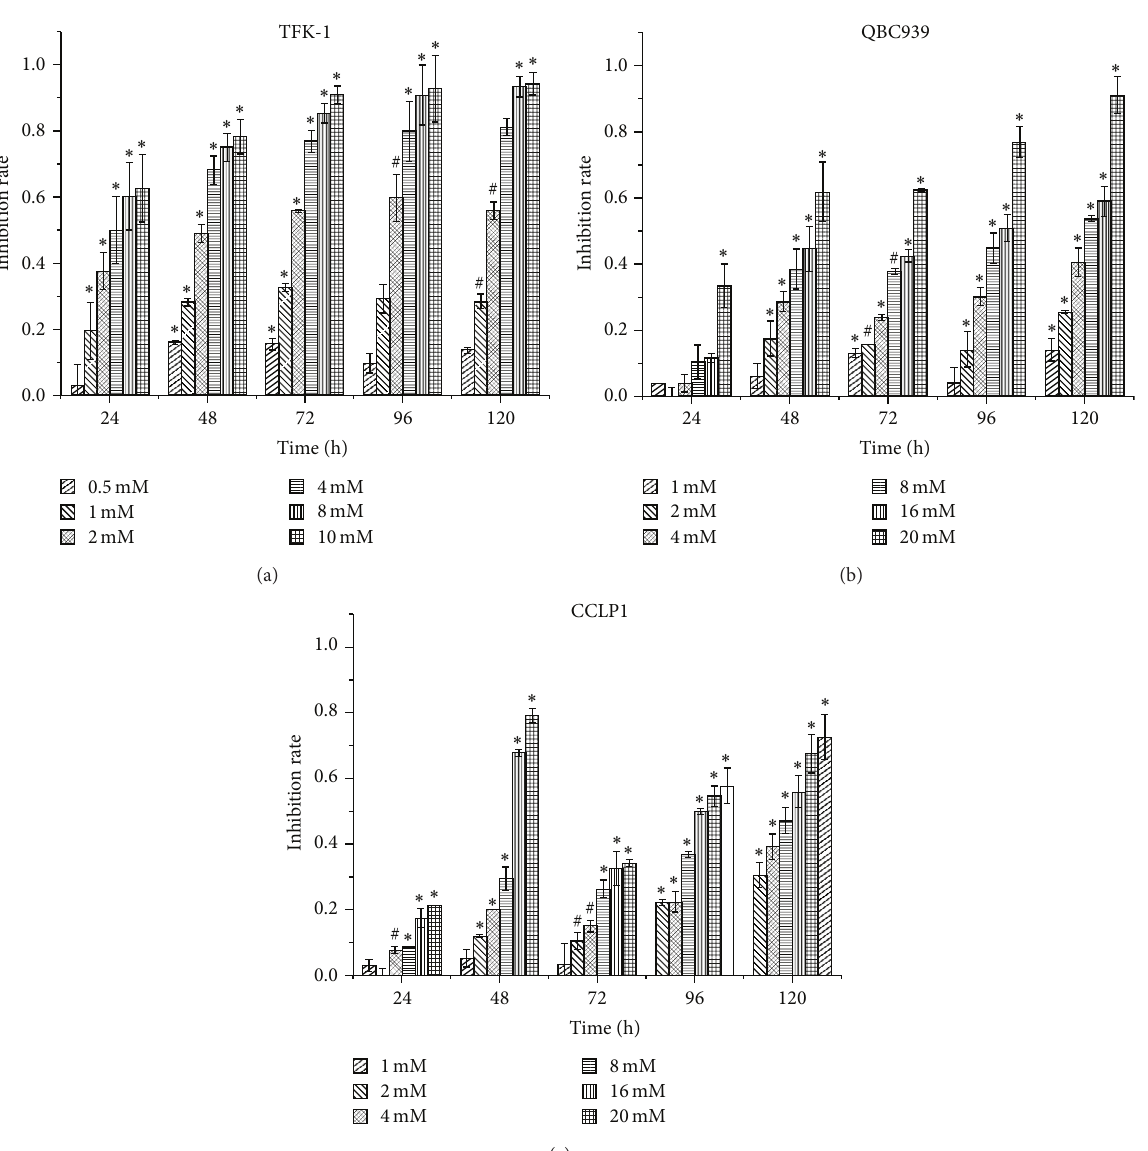
Figure 2: Effects of sodium valproate on cell growth of cholangiocarcinoma cell lines. After exposure to sodium valproate for 24 h–120 h, cell inhibition of TFK-1 (a), QBC939 (b), and CCLP1 (c) was measured by CCK-8 assay. All assays were conducted at least in triplicate. The inhibition rate was in comparison with untreated cells. ∗ 𝑃 < 0.05 and # 𝑃 < 0.01